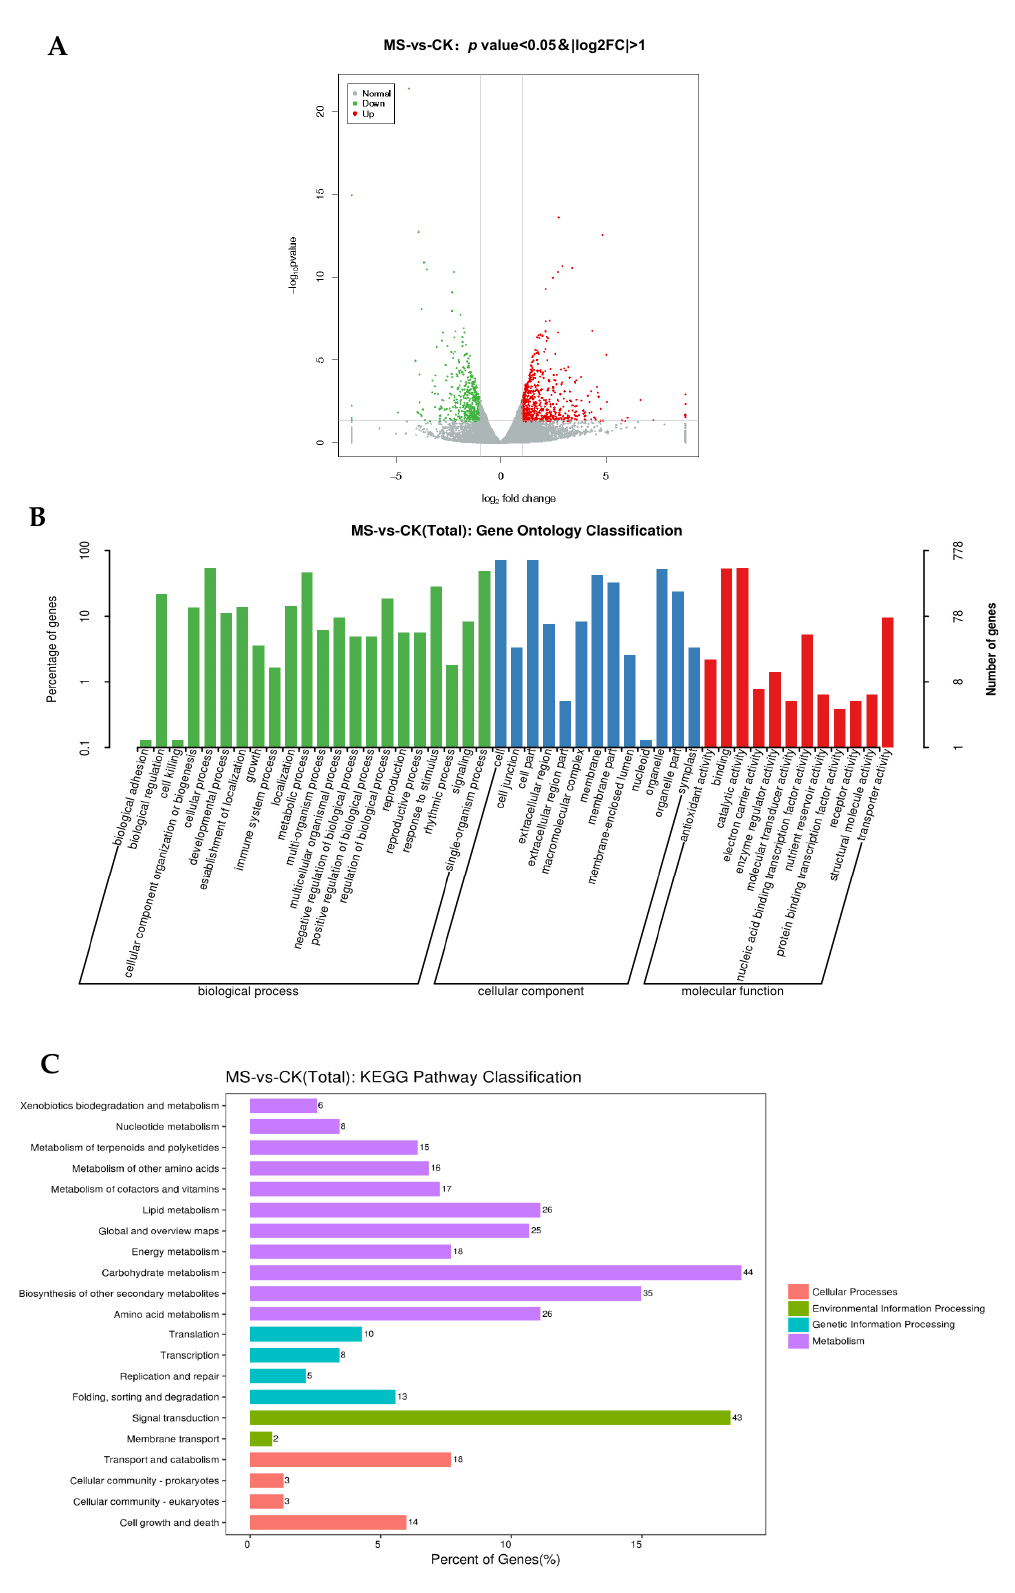
Figure 4. Functional enrichment analysis of differentially expressed genes (DEGs) between CK and MS. ( A ) Volcano plot of all detected genes between CK and MS; ( B ) GO enrichment of DEGs between CK and MS; ( C ) KEGG pathway analysis of DEGs between CK and MS. CK: normal fruit; MS: mildly watercored